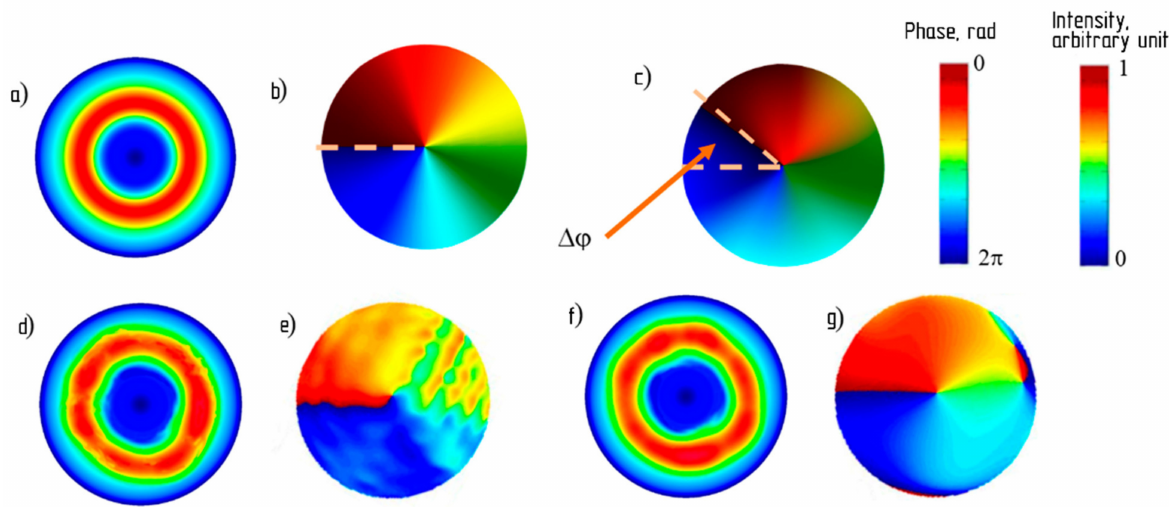
Figure 5. Illustration of the vortex signal generated by the considered V-FBG: ( a , d , f ) characterize the amplitude profile; ( b – e , g )—phase profile; ( a , b )—an ideal case; ( c ) vortex in case λ 0 < Λ Br , the phase goes beyond 2 π , an angle ∆ ϕ appears. On ( d – g ): λ 0 = Λ Br ; ( d , e )—significant distortions due to wandering of the input radiation intensity; ( f , g )—with apodization g ( z ) = sin 2 z . The intensity value (in color display) is normalized to the value I 0 , see Figure